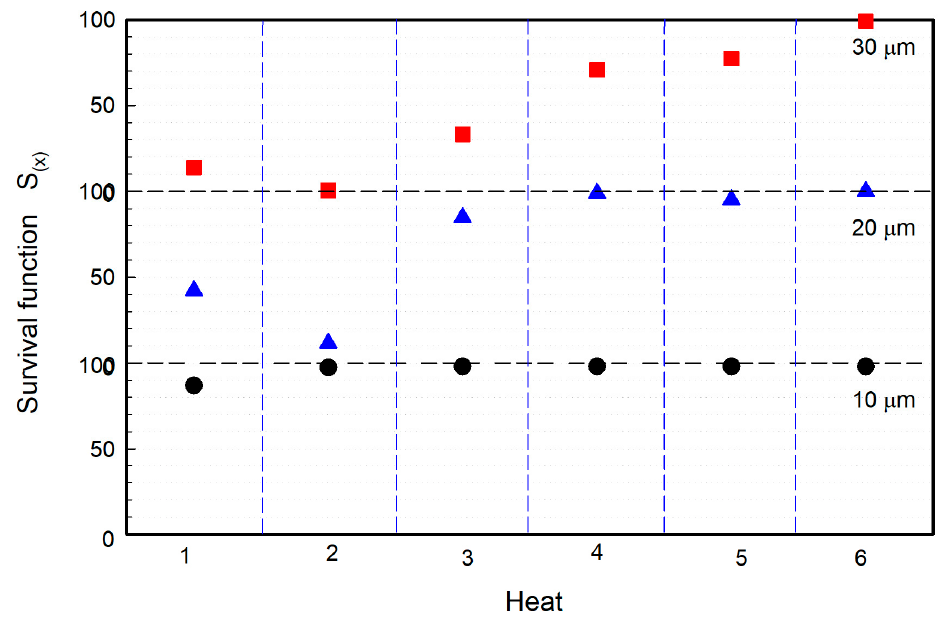
Figure 14. Survival function S (x) for different “critical” inclusion